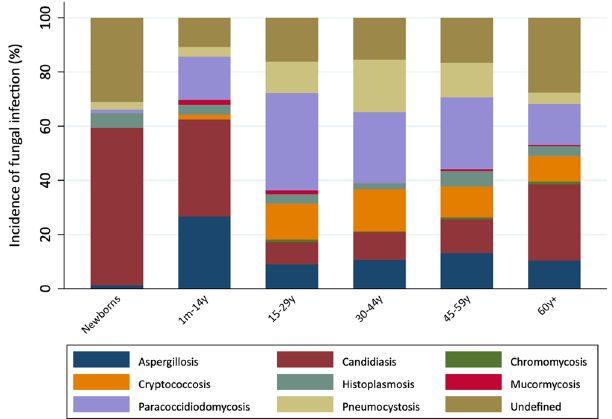
Figure 3. Age distribution of fungal infections in autopsy reports between 1930 and